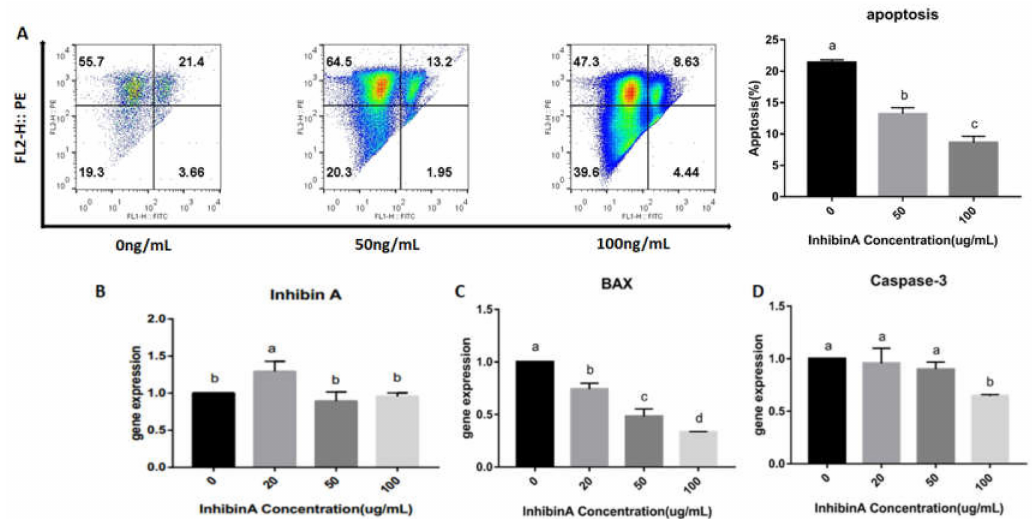
Figure 6. Flow cytometric analysis of GCs cultured under the treatments of di ff erent inhibin A doses (50 and 100 µ g / mL). The Y axis shows the analyzed cell counts for apoptosis while the X axis indicates the doses of inhibin A DNA content of cells stained by PI staining. The analyzed cell counts for apoptosis are indicated on the Y axis, and the doses of inhibin A are indicated on the X axis ( A ). Data shown as means ± SEM, n = 3, p < 0.05. mRNA expression of INH β A ( B ) and pro-apoptotic genes BAX ( C ) and Caspase-3 (D) in GCs cultured at di ff erent concentrations of inhibin A (20, 50, and 100 ng / mL) and the corresponding control (0 ng / mL). GADPH was used as a reference gene. The results are expressed as the mean ± SEM, n = 3. The bars labeled with completely di ff erent letters indicate a significant di ff erence, p <